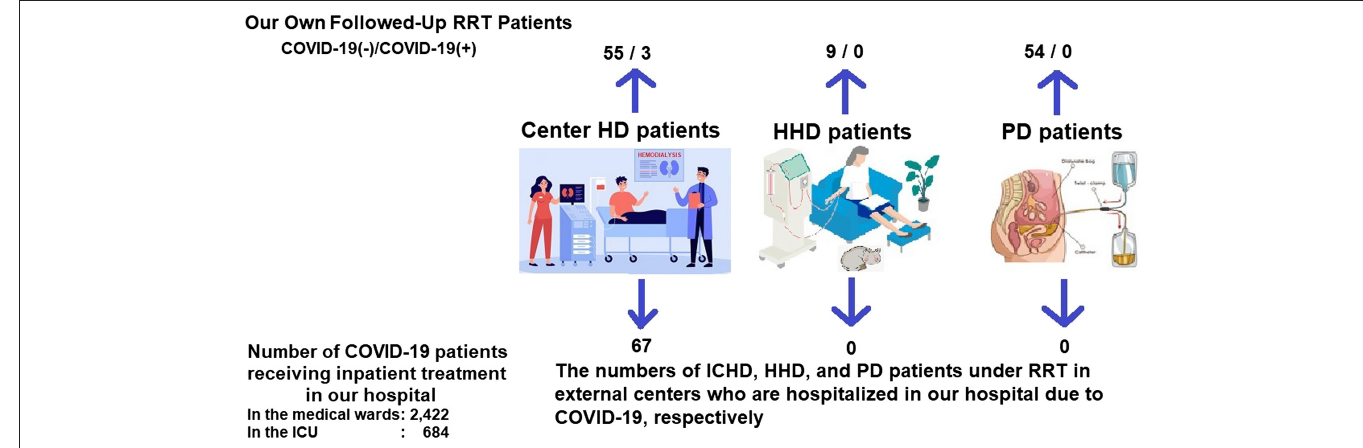
Figure 1. Visual summary of the distribution of the patients. HD, hemodialysis; HHD, home hemodialysis; ICHD, in-center hemodialysis; ICU, intensive care unit; PD, peritoneal dialysis; RRT, renal replacement